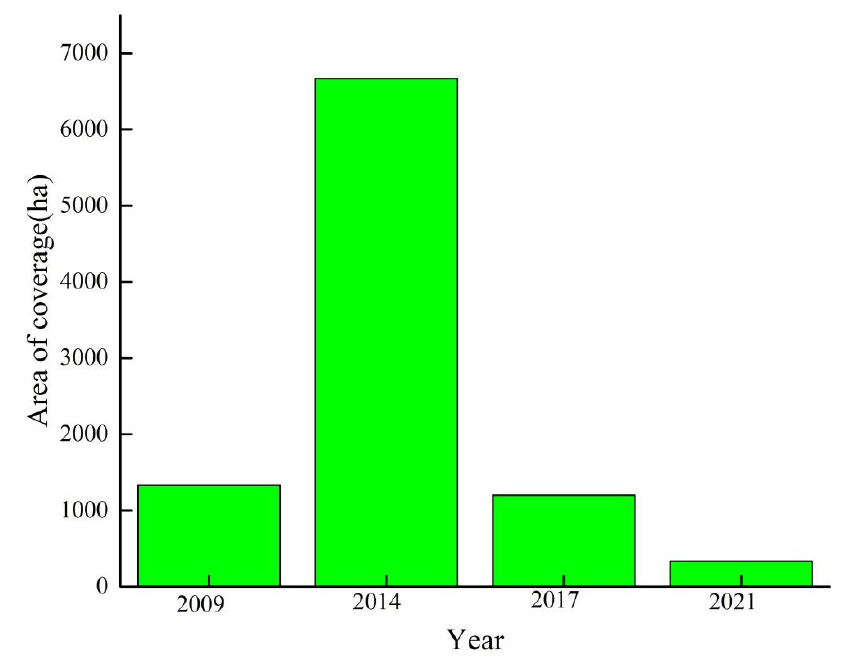
Figure 8. The area covered with water hyacinth in Hong Lake.